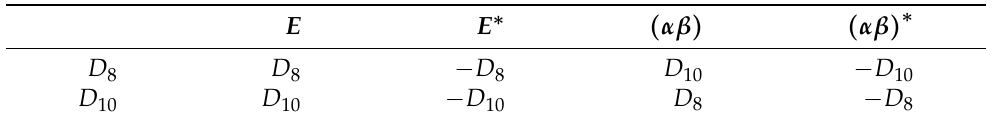
Table 1. The transformation properties of the dihedral angles D 8 and D 10 under the elements of the M S 4 molecular symmetry